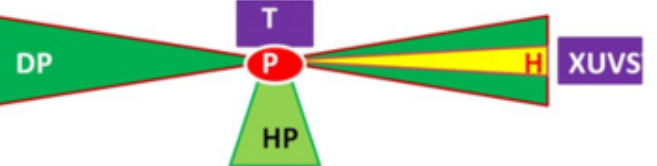
Figure 1. Experimental scheme. DP: driving pulse; HP: heating pulse; T: target; P: laser-induced plasma; H: harmonic emission; XUVS: extreme ultraviolet spectrometer. plasma; H: harmonic emission; XUVS: extreme ultraviolet